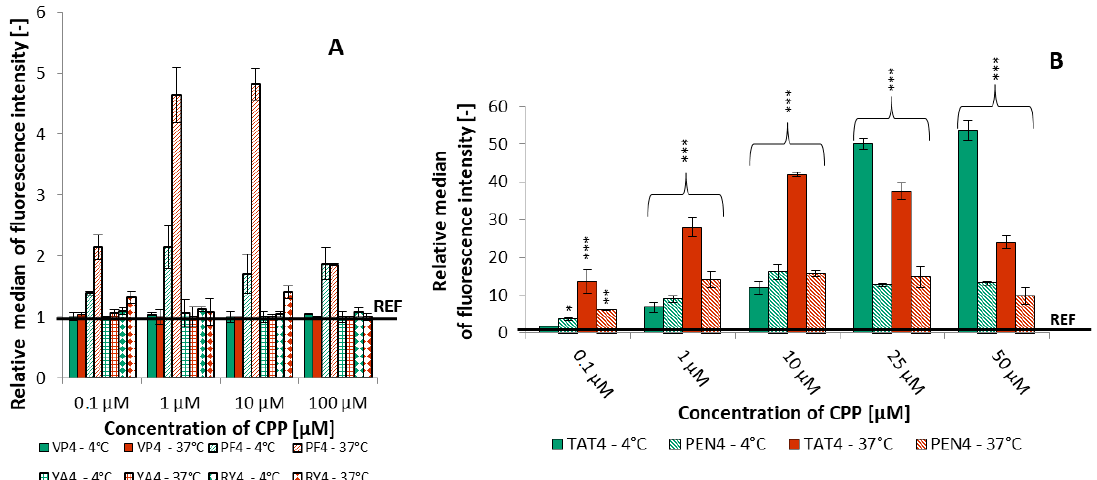
Figure 1. Comparison of fluorescently labeled polymer–peptide conjugates ( A ) VP4 , PF4 , YA4 , RY4 and ( B ) TAT4 , PEN4 examined at 37 °C (orange) and 4 °C (green) for 1 h, documenting the level of uptake in a wide range of concentrations. The heights of the columns show relative increase of the median fluorescence intensity of the cells incubated with the polymer–peptide conjugates compared with control polymer REF (value = 1) in respective concentrations. Level of significance is shown for each column against REF : *** for p < 0.001, ** is p < 0.01, and * p < 0.05.